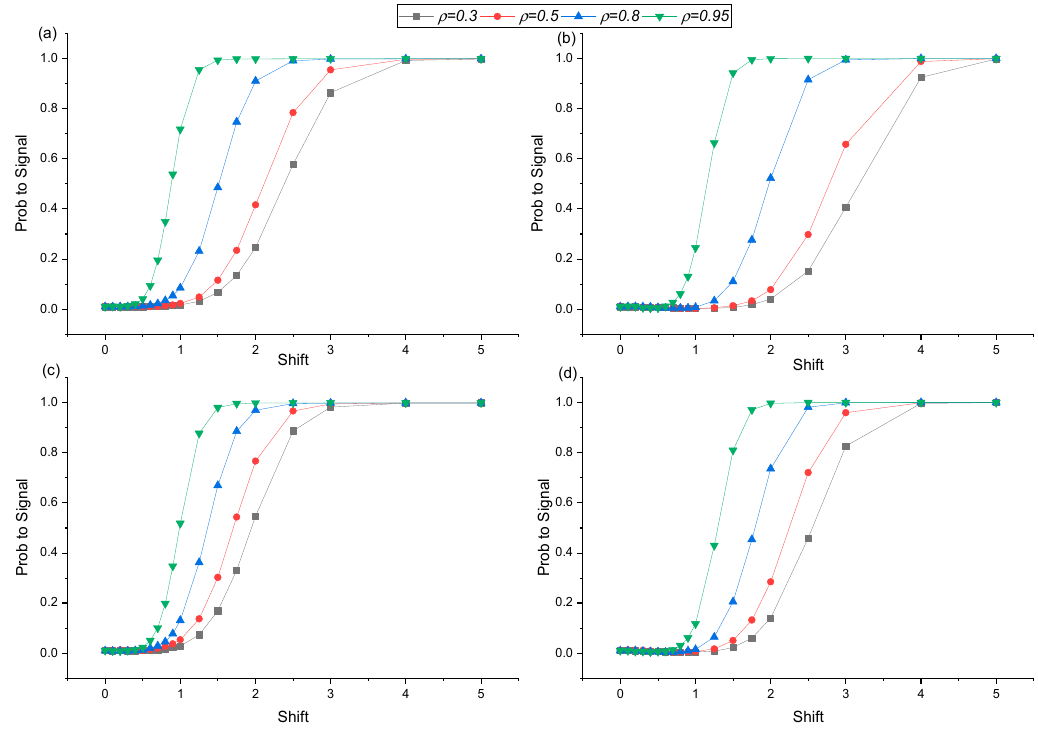
Figure 7. Probability to signal plot for di ff erent correlations using m = 30, n = 10 and α = 0.01 of: ( a ) M 3 and m 1 = 6; ( b ) M 3 and m 1 = 9; ( c ) M 4 and m 1 = 6; ( d ) M 4 and m 1 = 9 .